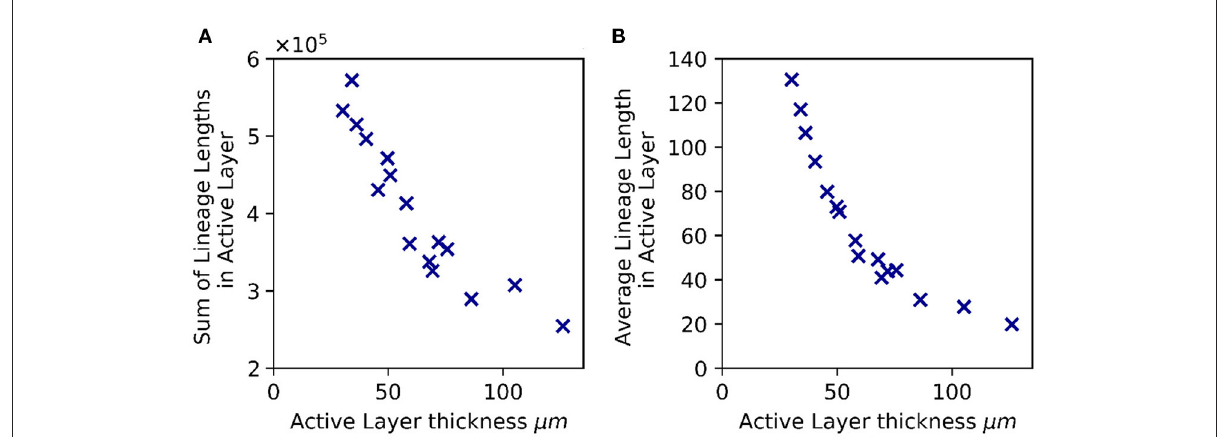
FIGURE5 Active layer thickness controls patterns of lineage length, hence de novo diversity. (A) Total de novo diversity in the active layer. The sum of the lineage lengths of all microbial agents in the active layer is plotted against the active layer thickness (averaged across the biofilm interface) for 16 biofilms that have reached 50,000 agents. (B) Average lineage length of a microbial agent in the active layer, plotted vs. the active layer thickness. In both panels, as in Figure 2, the active layer thickness was varied by changing the bulk nutrient concentration ( S bulk ) and the maximum specific growth rate ( µ max ). The values of S bulk and µ max corresponding to these simulations are shown in Supplementary table 1 together with the active layer thicknesses. The rest of the simulation parameters are as in Table